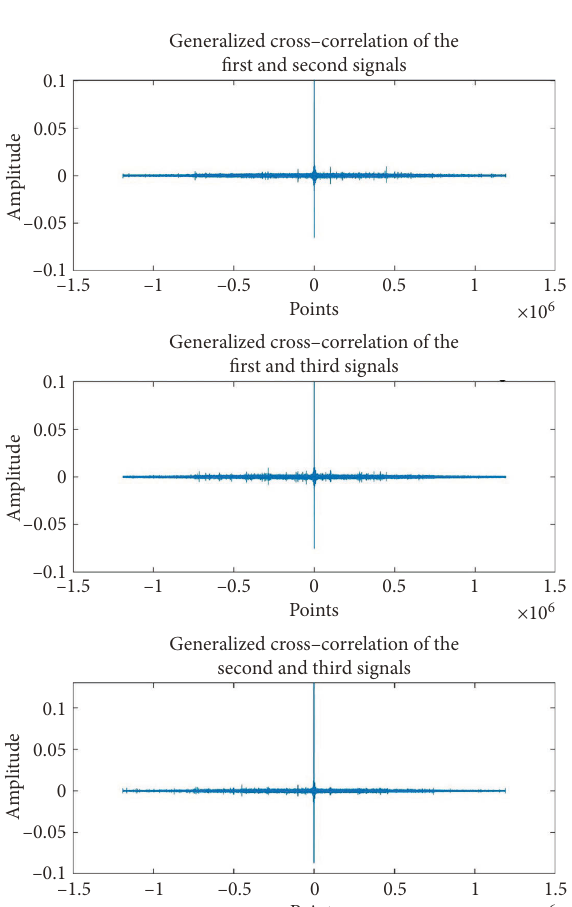
Figure 29: Generalized cross-correlation.